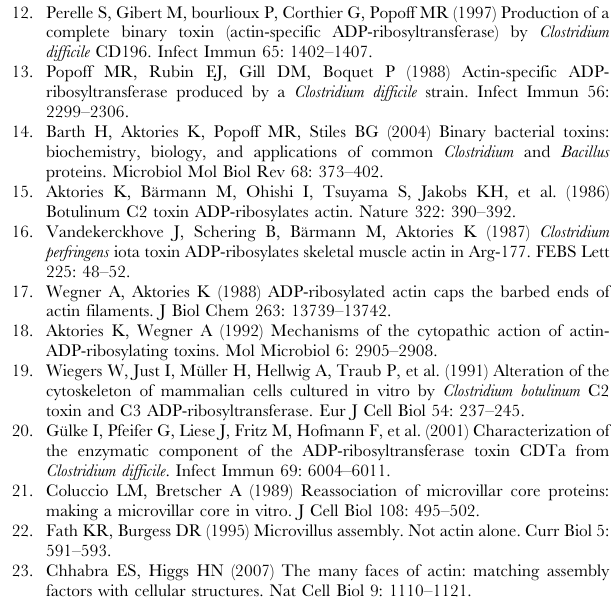
difficile per m m mucosal surface was determined. Nap1/027 infected mice treated with control serum were set 100%. (C) Quantification of C. difficile directly adjacent to the epithelium in the colon. The number of C. difficile per m m mucosa was determined as in B. 40 ng/ml CDTb. The toxin was added to the cell culture medium. Thereafter, a picture was taken every 90 sec. After , 50 min the formation of toxin-induced protrusions started. The maximum of protrusion formation was observed after , 4 h. The incubation time (h:min) is indicated in the movie. Scale bar represents 20 m m. place where several EB3-GFP comets approach the cell cortex, cross the cell border and form a microtubule-based protrusion. Pictures were acquired every 2 sec. The elapsed time (min:sec) is indicated in the movie. Contrast was inverted. Scale bar